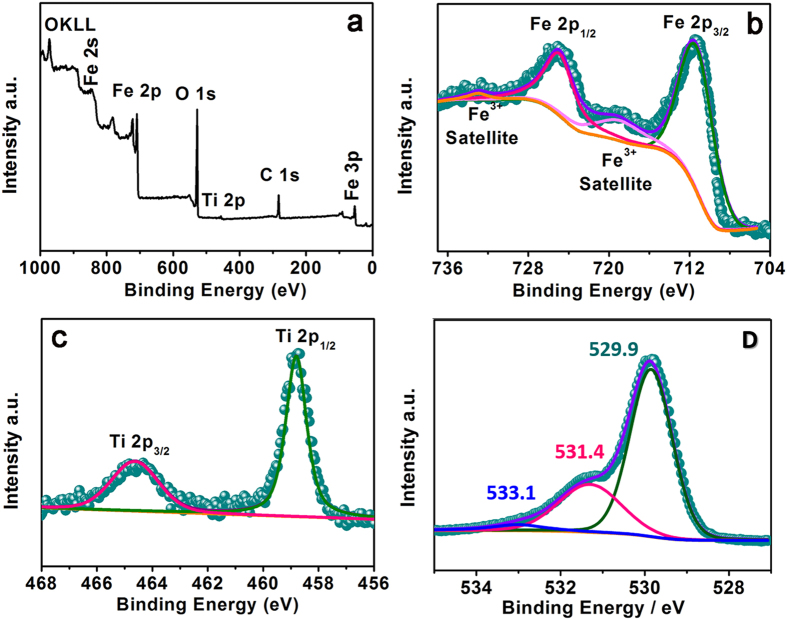
(a) XPS spectrum of a wide survey scan for the TiO2@Fe2O3-600 nanotube arrays, and high-resolution peaks of (b) Fe 2p, (c) Ti 2p, (d) O 1 s region.